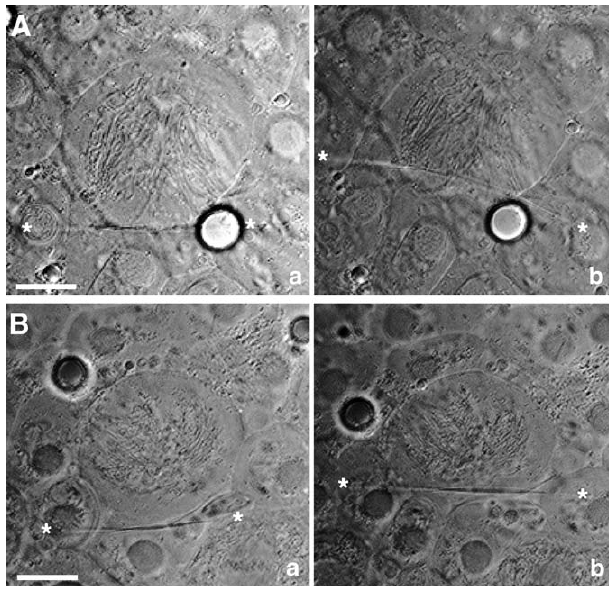
Figure 4. Cortical Stiffness Correlates with Local Density of Cortical Actin (A) After the spindle was repositioned and collapsed to induce cortical flow, we tested the stiffness of the actin-dense region of the cortex. (a) The needle (marked with asterisks) in its initial position, tangential to the actin-rich cortex. (b) After the needle was pushed against the cortex, the stiff cortex deflected the needle. (B) After rotating the cell in (A) by 180 8 , the cortical stiffness of the actin- depleted region of the cortex was tested. (a) The needle (marked with asterisks) in its initial position, tangential to actin-depleted cortex. (b) After the needle was pushed against the cortex, the relaxed cortex was deformed by the needle without deflecting it. F-actin was labeled using low-level Alexa Fluor 488 phalloidin to monitor flow. Bars, 10 l m. spindle stabilized at the metaphase-anaphase transition. This failure of delivery suggests that at later stages, when the central spindle is remodeled to produce the polar focusing of microtubules and the splaying of bundles, dynamic micro- tubules may be required.